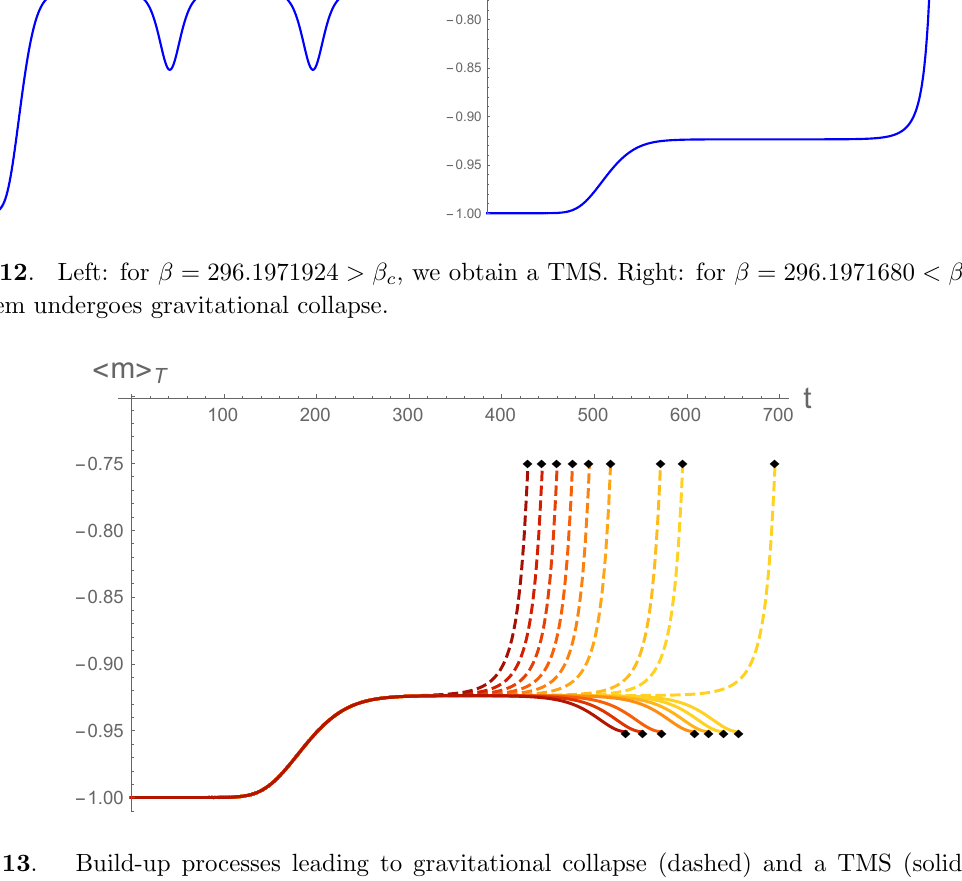
(cid:12)rst reaches (cid:0) 0 : 75; solid ones until h m i T